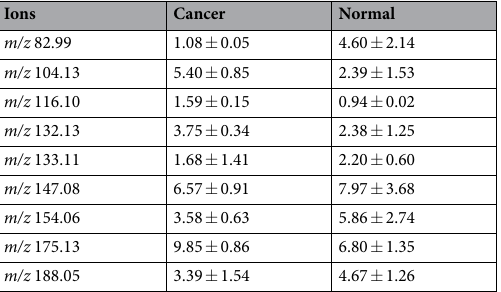
Table 1. Comparison of relative abundances between cancer tissues and normal tissue. In cancerous tissue, the relative abundance values of m/z 104.13, m/z 116.10, m/z 132.13, and m/z 175.13 were increased, while the relative abundance values of m/z 82.99, m/z 133.11, m/z 147.08, m/z 154.06, and m/z 188.05 were